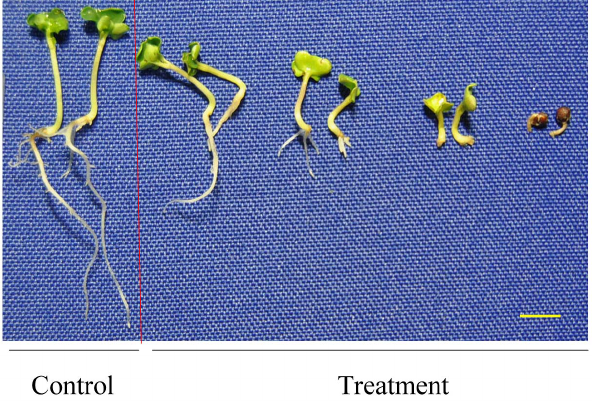
Figure 3. The adventitious roots of ZS12 induced by waterlog- ging at seedling stage. Red bars=1.0 cm.